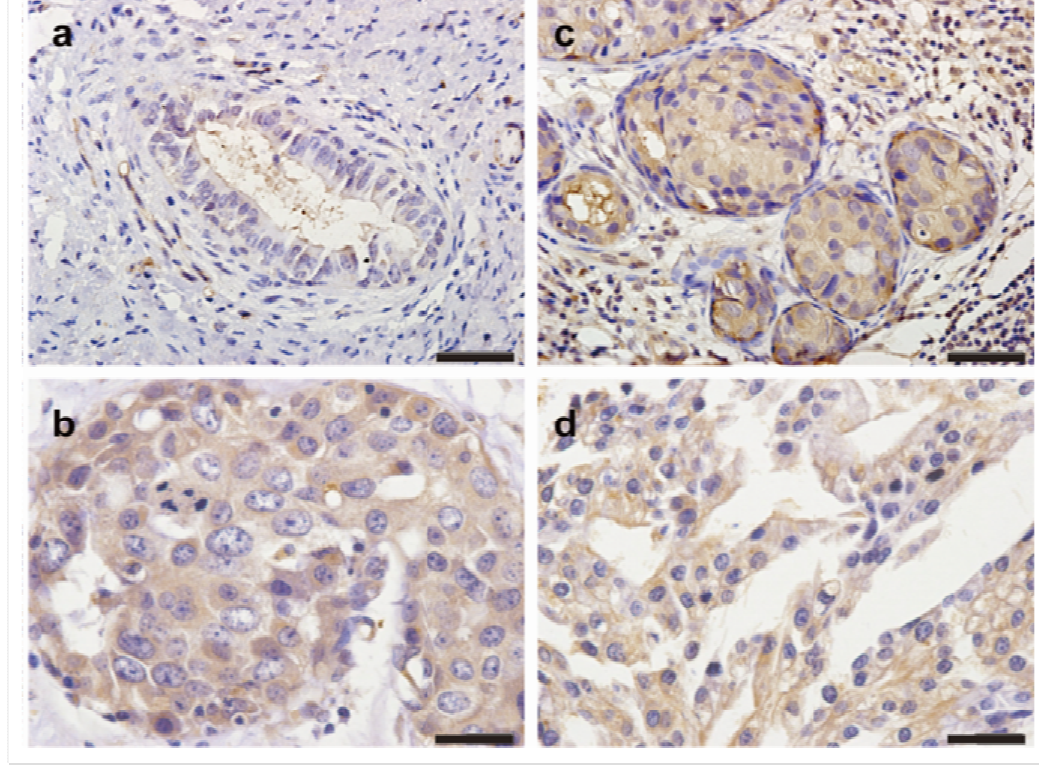
Figure 1. Immunohistochemical detection of TMPRSS4 expression in formalin-fixed paraffin-embedded triple-negative breast cancer (TNBC) tissue samples. ( a ) Negative TMPRSS4 immunostaining in another TNBC tissue; ( b – d ) Positive TMPRSS4 immunostaining in TNBC tissue. Positive TMPRSS4 immunostaining in TNBC tissues appeared as brown particles, which were mainly localized within the cytoplasm and cell membrane in the nests of breast